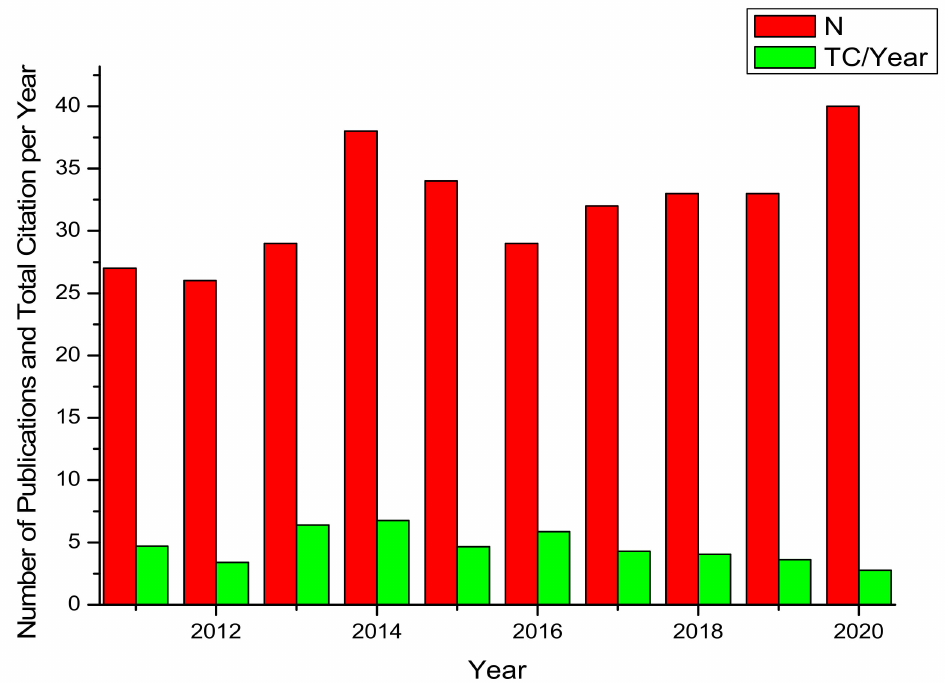
Figure 1. Number of publications (N) and total citation per year from 2011 to